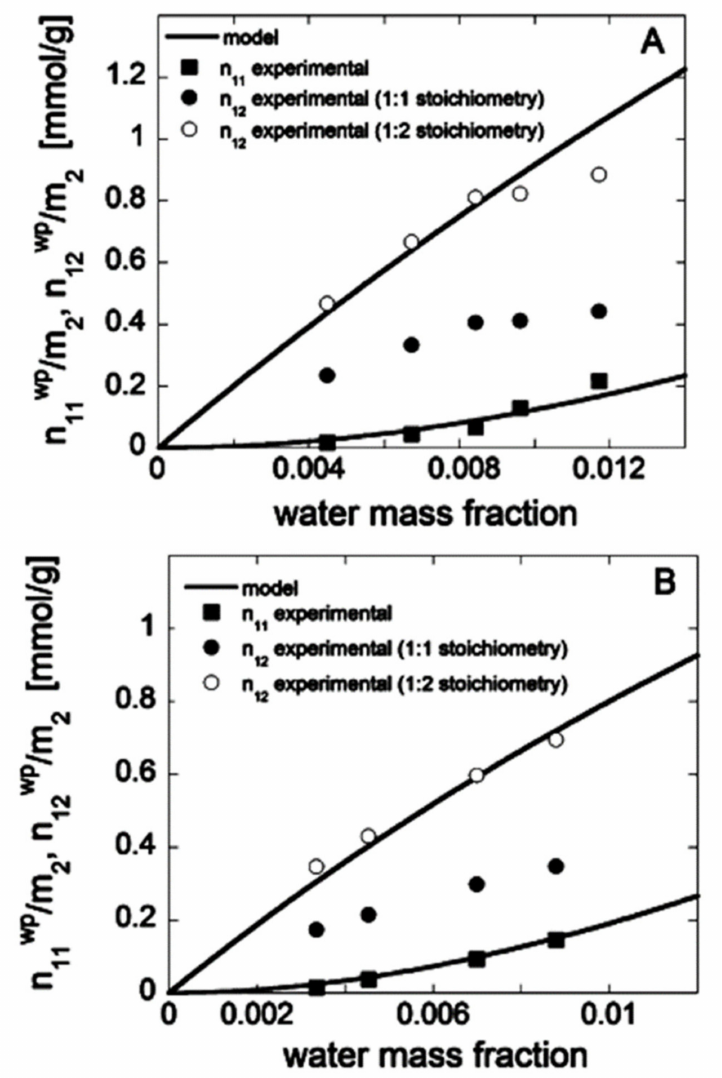
Figure 8. ( A , B ) Comparison of predictions of the NET-GP − NRHB model with experimental results for ( A ) 6FDA-ODA and ( B ) 6FDA-6FpDA (used with copyright permission)